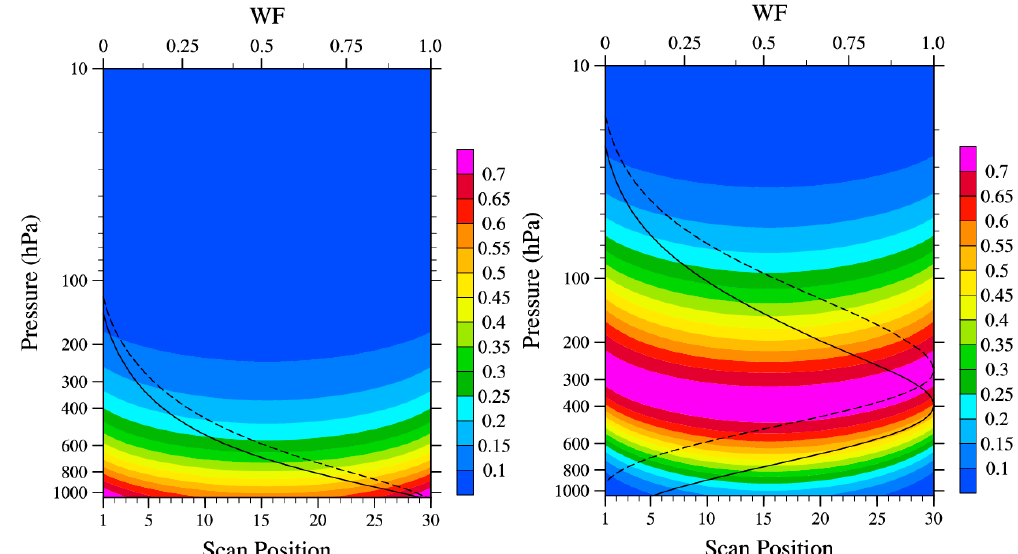
Figure 2. Angular dependence of WFs (shaded in color) for MetOp-B AMSU-A channel 3 (left panel) and channel 6 (right panel) and the vertical profiles of the normalized WF at nadir (FOV 15, solid curve) and at the largest scan angle (FOV 30, dashed curve).